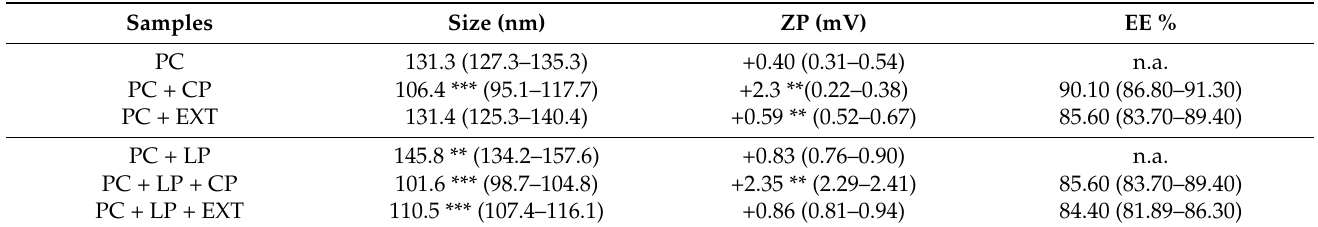
Table 1. Median diameter, zeta potential and encapsulation efficiency of liposomes.